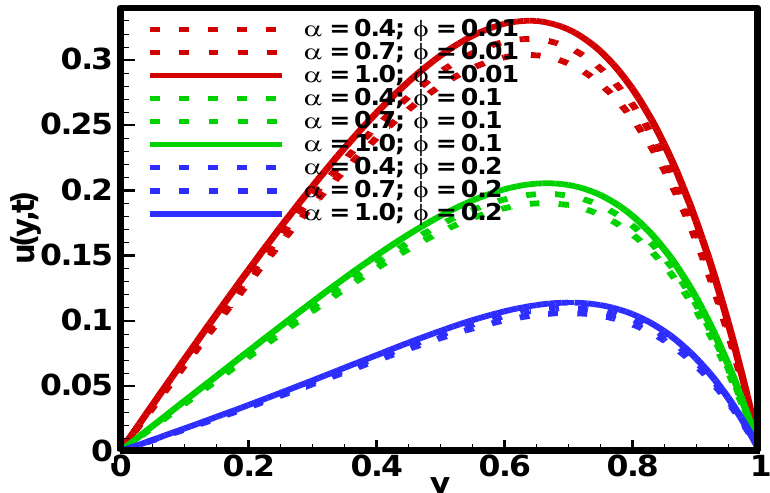
= 0.1, Gr = 5, λ β = 0.1, Pr = 21, 1 2